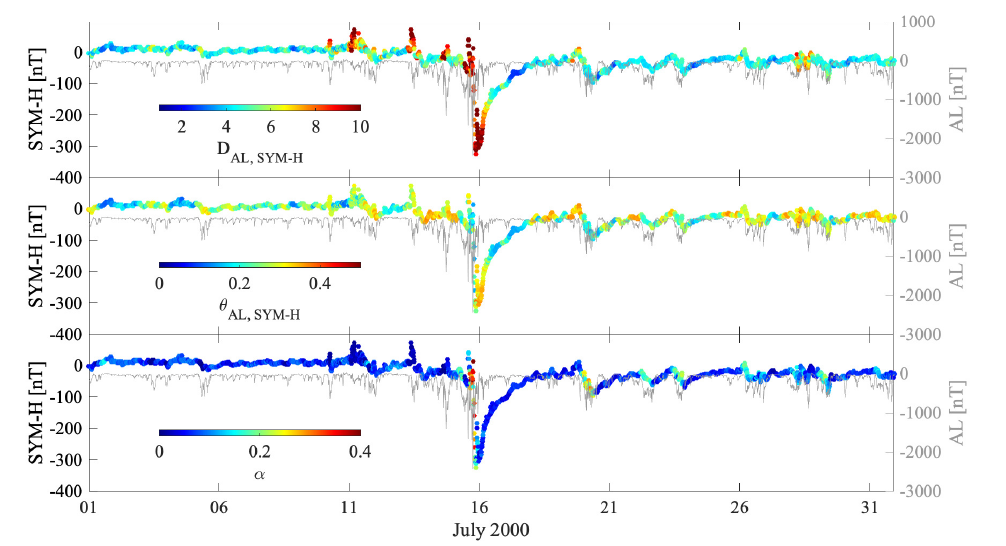
Figure 9. Behavior of the co-dimension D AL , SYM − H (upper panel), the co-persistence θ AL , SYM − H (middle panel), and the co-recurrence ratio α during the Bastille Day geomagnetic storm across the SYM-H index. The time behavior of the AL index is reported in gray for